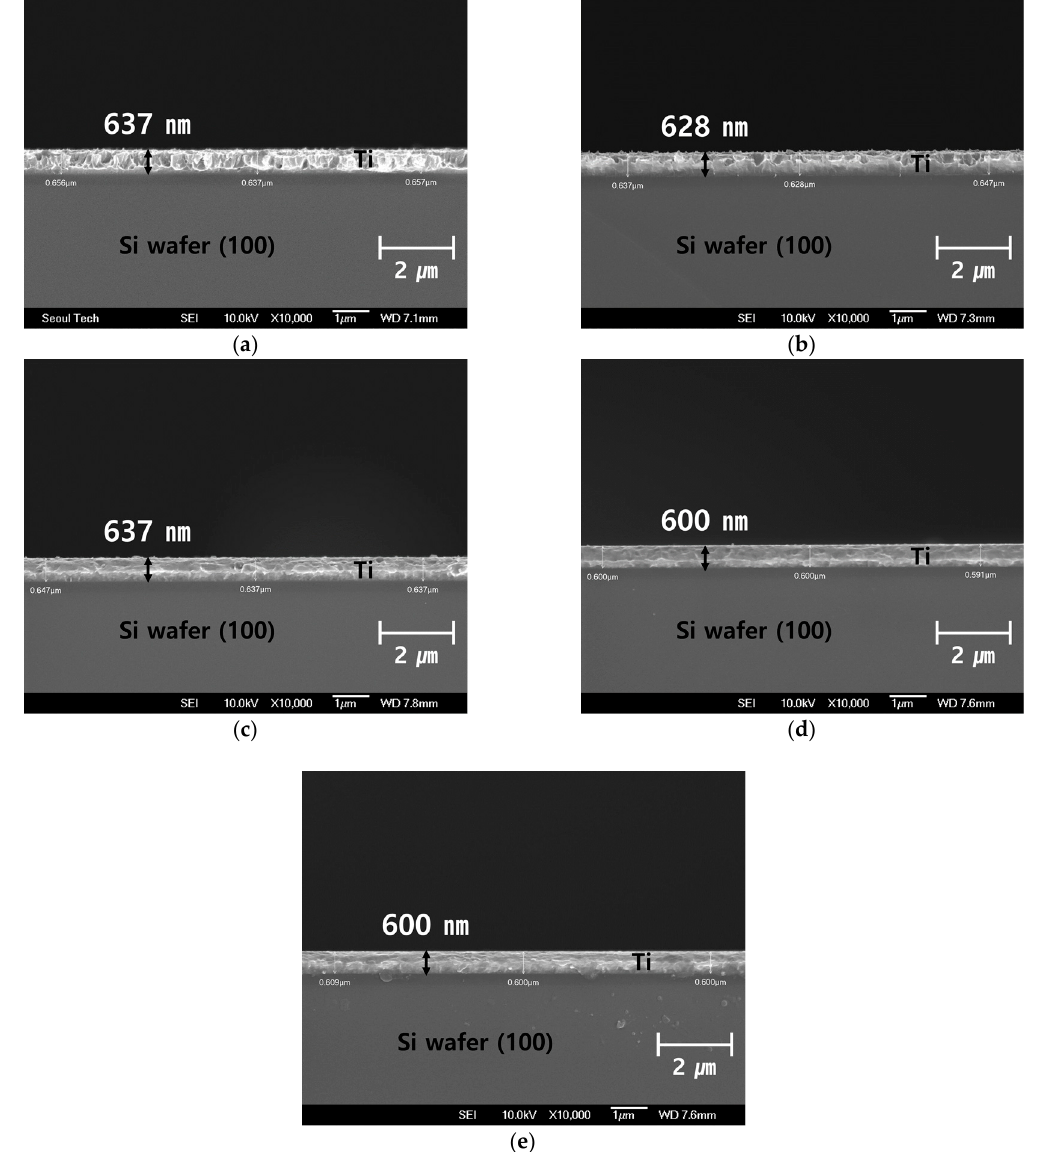
Figure 3. SEM image for Ti thin film thickness measurement: ( a ) 28.8W; ( b ) 57.6W; ( c ) 86.4W; ( d ) 115.2W; ( e ) 144W.